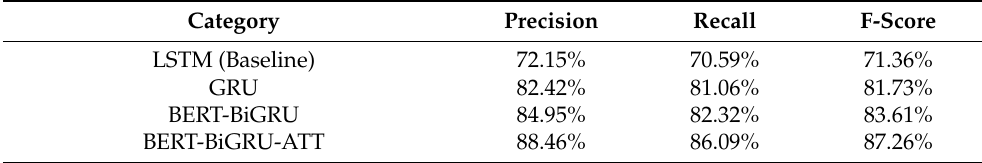
Table 4. Comparison of relationship classification results on test